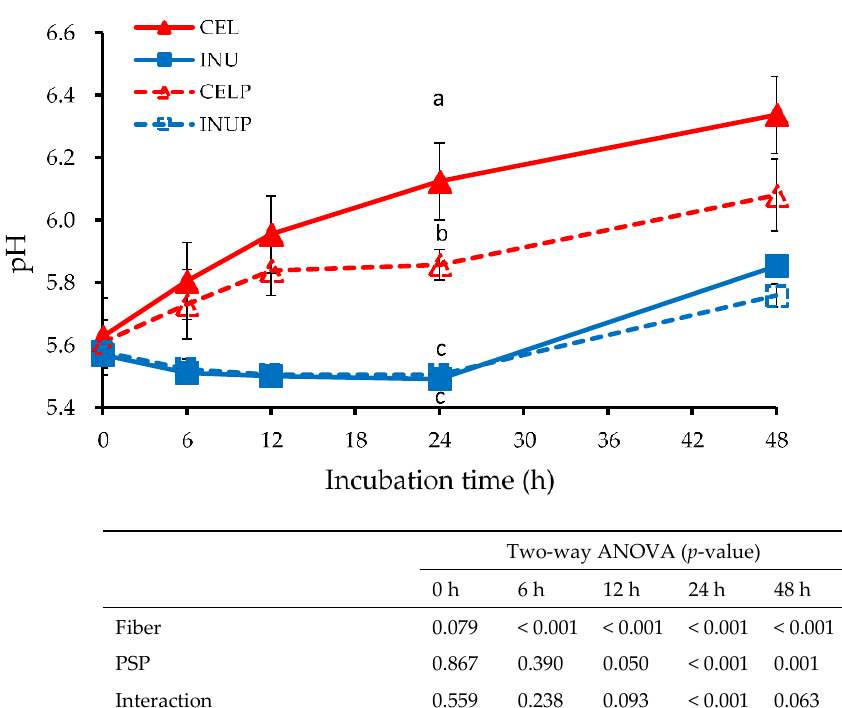
Figure 4. The pH values for each sample treatments during in vitro colonic fermentation of 3% cellulose (CEL), 3% cellulose + 0.16% PSP (CELP), 3% inulin (INU), and 3% inulin + 0.16% PSP (INUP). Values are reported as mean and standard error ( n = 5). Two-way ANOVA was performed to assess the effect of fiber (cellulose and inulin), PSP, and their interaction. If the variance was observed in the main effect of the interaction, Tukey’s test was used for this comparison. Mean values at the same time point designated by different letters (a–c) are significantly different ( p < 0.05).